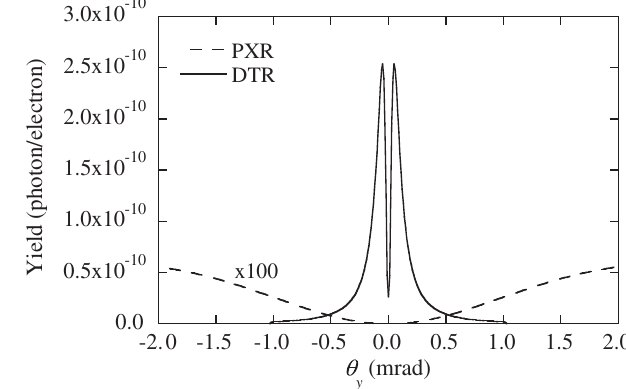
FIG. 4. Dependence of the beam size estimates from the distance between the crystal and the detector. Silicon; electron energy 255 MeV; observation angle Θ D ¼ 32 . 2 °; σ x ¼ 0 . 3 mm; σ ¼ 0 . 8 mm. y